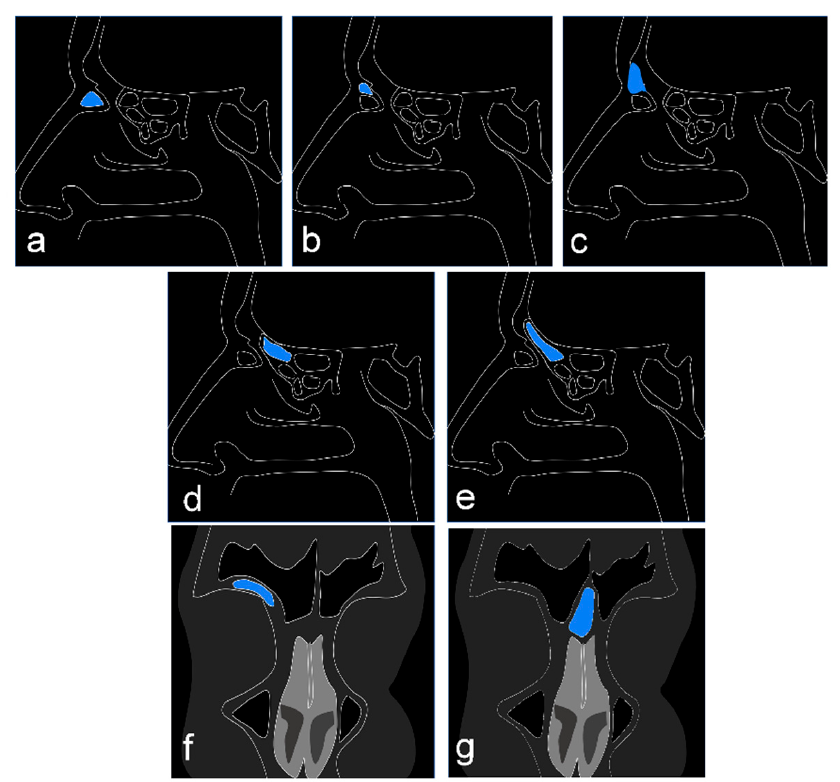
Figure 1. Diagram showing the cell types studied according to the International Frontal Sinus Anatomy Classification. Sagittal CT section: ( a ) cell agger nasi; ( b ) supra agger nasi cell; ( c ) frontal supra agger cell; ( d ) supra bulla cell; ( e ) frontal supra bulla cells. Coronal CT section: ( f ) supraorbital ethmoid cell; ( g ) frontal septal cell.